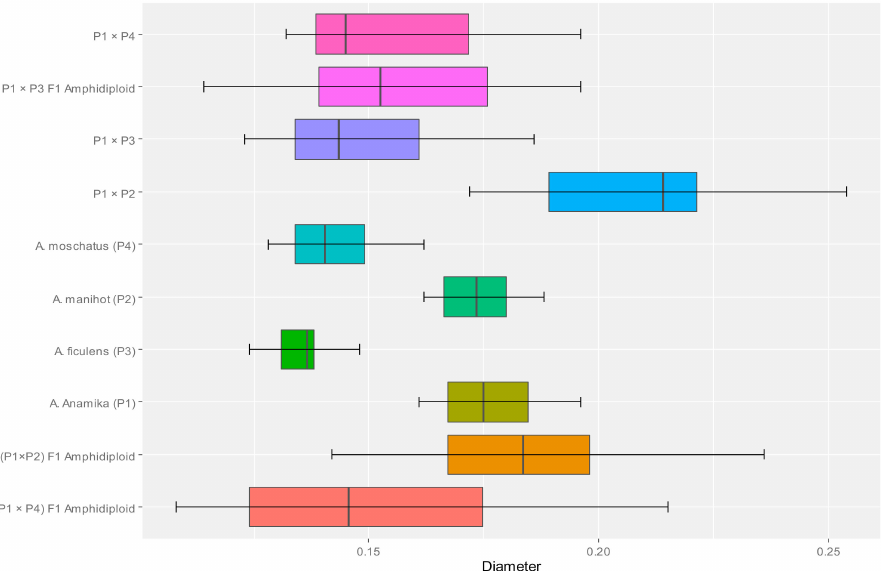
Figure 2. Box plot depicting the variation in pollen diameter ( µ m) among parents and crosses. The dashed line shows the overall mean (standard deviation = 0.022). Table 3. Pollen viability and pollen germination in A. esculentus cv. ’Arka Anamika’, A. manihot , A. ficulens and A. moschatus , their F 1 and amphidiploid F 1